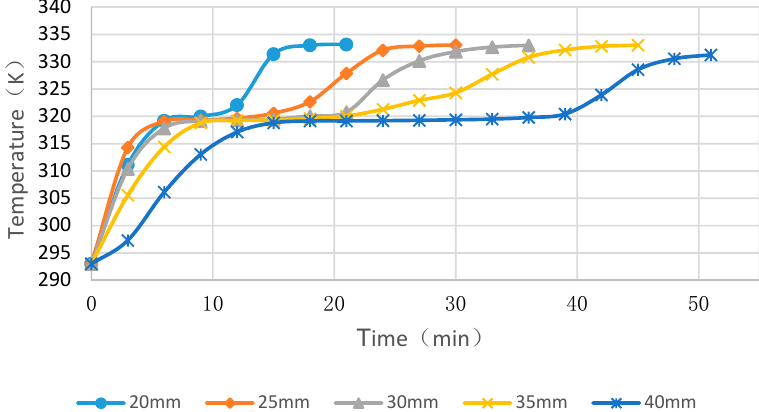
Figure 12. PCM cylinder module melting times for different diameters when the hot water temperature is 60 °C.